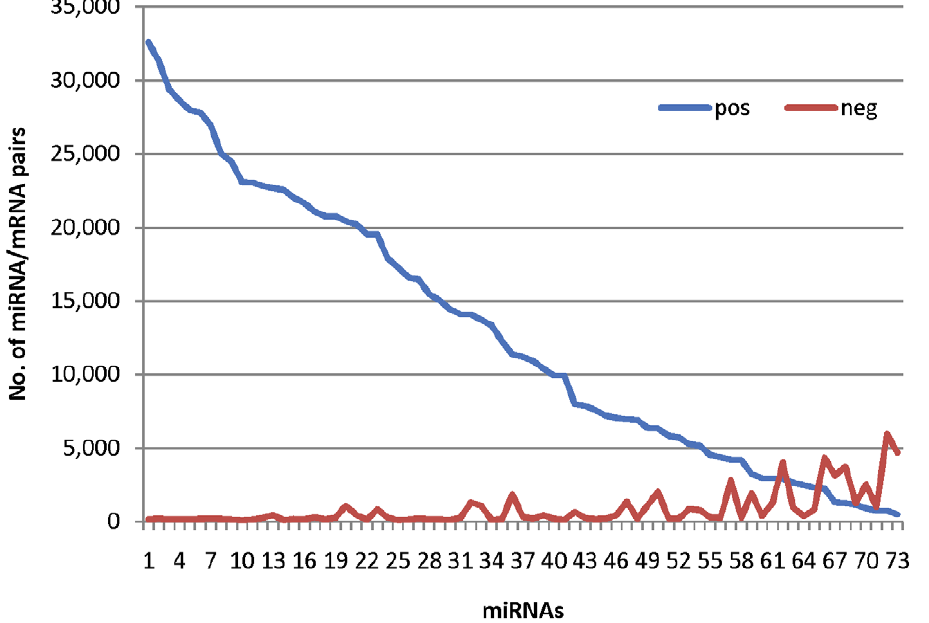
Figure 5. Comparison between the positively and negatively correlated pairs for each differentially-expressed microRNA (73 probes are involved for 65 unique microRNAs).